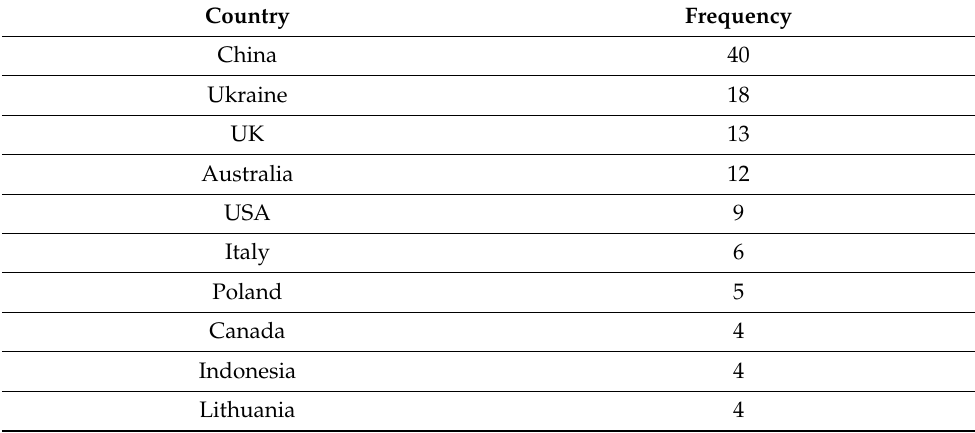
Table 2. Contributing Countries (‘Authors’ compilation).